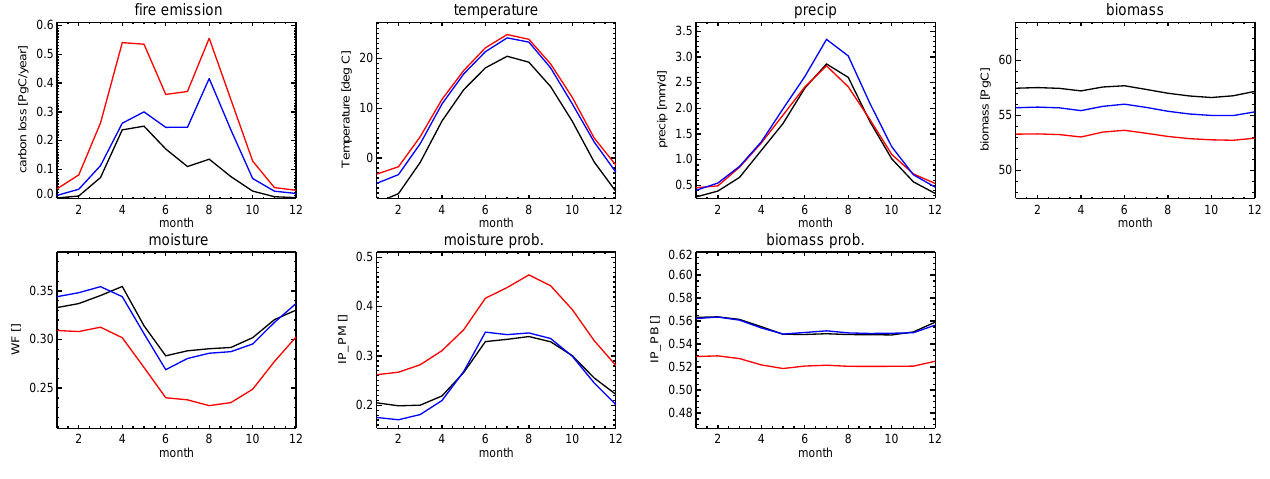
Fig. 10. Central Asia (CEAS): seasonal variation in fire carbon emissions [TgCyr − 1 ], climate parameters (temperature [deg C] and precip- itation [mmd − 1 ]), aboveground biomass [g Cm − 2 ] and moisture and biomass constrained fire occurence probabilities (ip pb and ip pm []) averaged over the period 2075–2099. Red: ECHAM/MPI-OM climate forcing; blue: CCSM climate forcing; black: control simulation with constant climate.